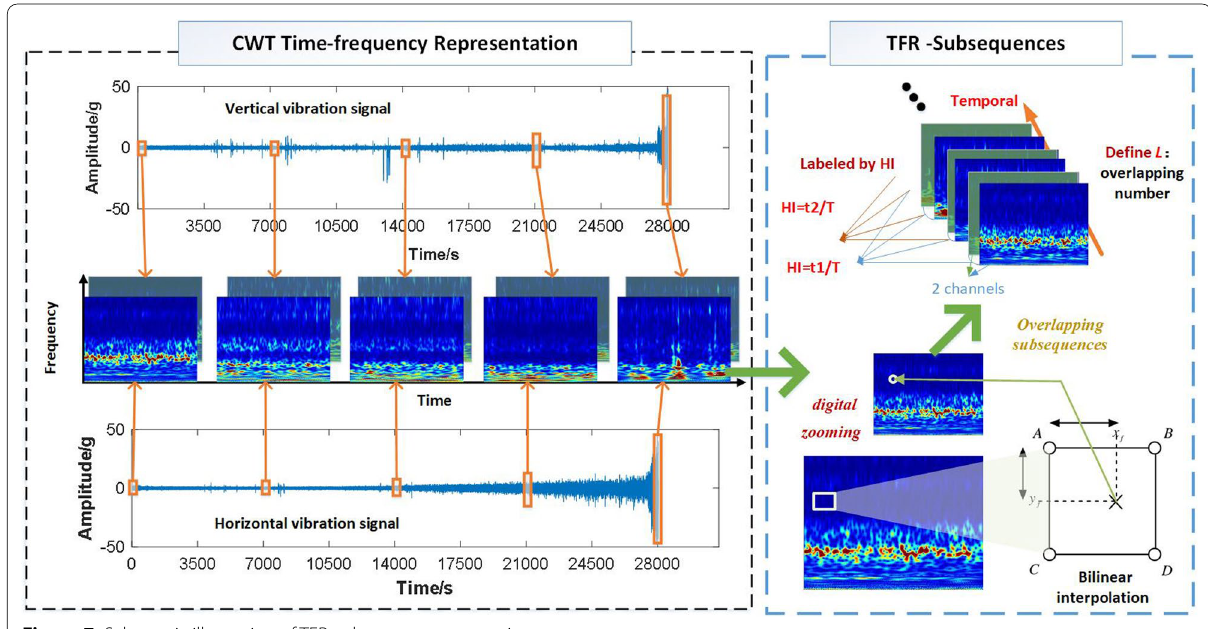
Figure 7 Schematic illustration of TFR-subsequence